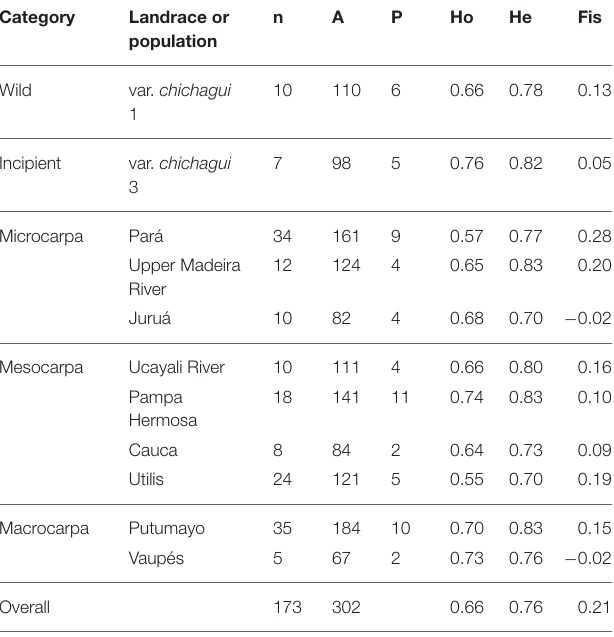
TABLE 3 | Genetic parameters estimated with 17 SSR loci for Bactris gasipes var. chichagui types 1 and 3, and seven landraces and two non-designated populations of var. gasipaes in the Core Collection of the Peach palm Active Germplasm Bank, Manaus,